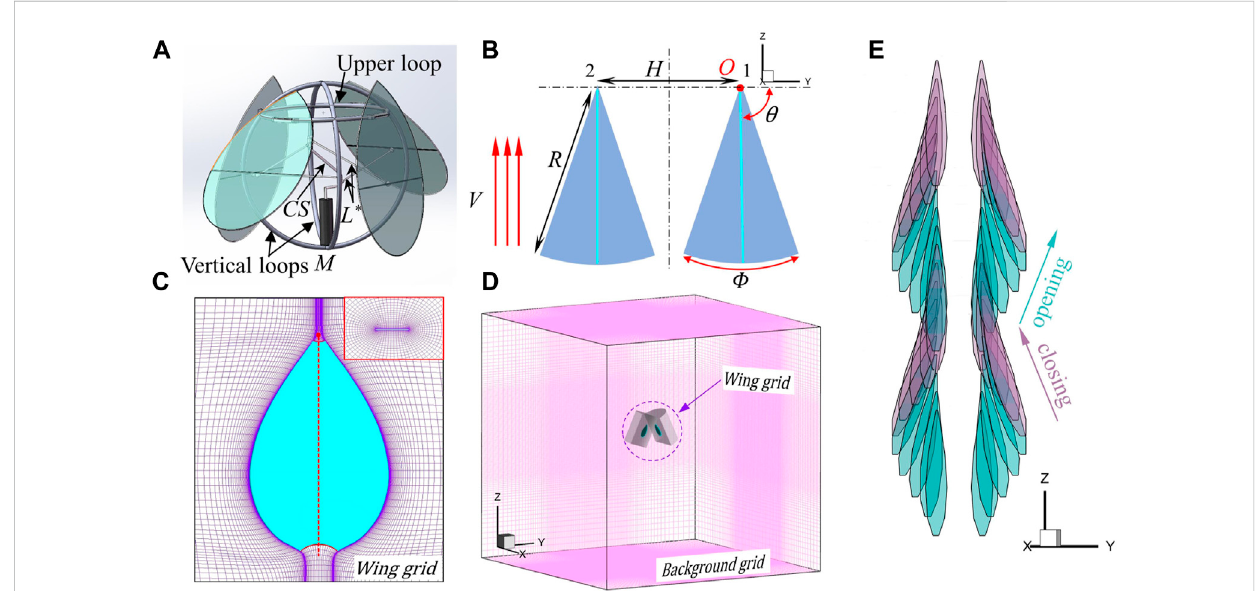
FIGURE 1 (A) Three-dimensional model ofthejelly fi sh-like fl ying machine manufactured byRistrophand Childress [13]. The prototype pullsin and pushesout four wings by using a motor ( M ) to rotate a crankshaft ( CS )that connects via a link ( L *) to each wing. The body of the fl yer consists of two crossed vertical loops that support the motor below and a horizontal upper loop. More detailed information about this fl yer can be found in [13]. (B) Simpli fi ed wing-pair model.Here, V istheup- fl ightspeed; θ representsthewings ’ baseopeningangle; R and H denotethewinglengthandthedistancebetweenthetwo pivot points, respectively. Tworigid platesare driven to fl ap with prescribed mirror-symmetricsinusoidal pitching motions of peak-to-peak amplitude Φ . (C) Wing grid with an inset showing the grid at a half wing length section. (D) Over-set grid system. (E) Instantaneous snapshots of the fl apping wings during ascending fl ight. The prototype in (A) achieves upward fl ight by closing and opening an opposing pair of wings, just like the jelly fi sh which periodically contract and expand their bell-shaped